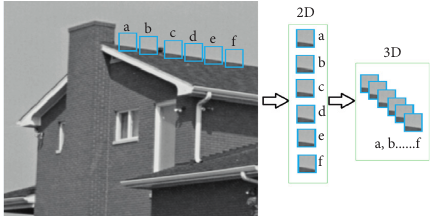
Figure 3: The relationship between 2D and